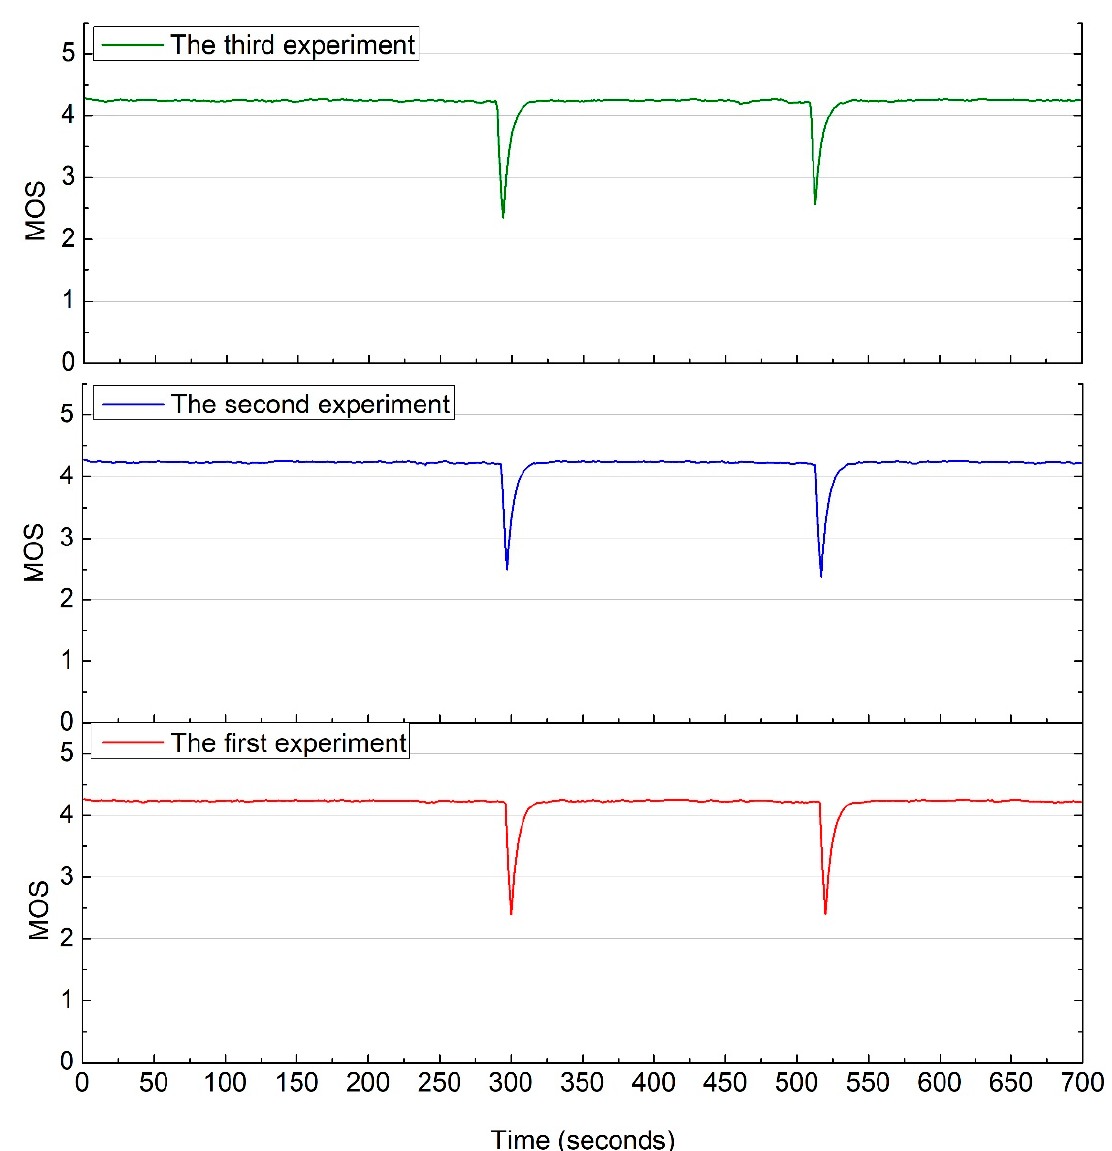
Figure 26. The MOS of three experimental results of the LTE event A3 handover mechanism.